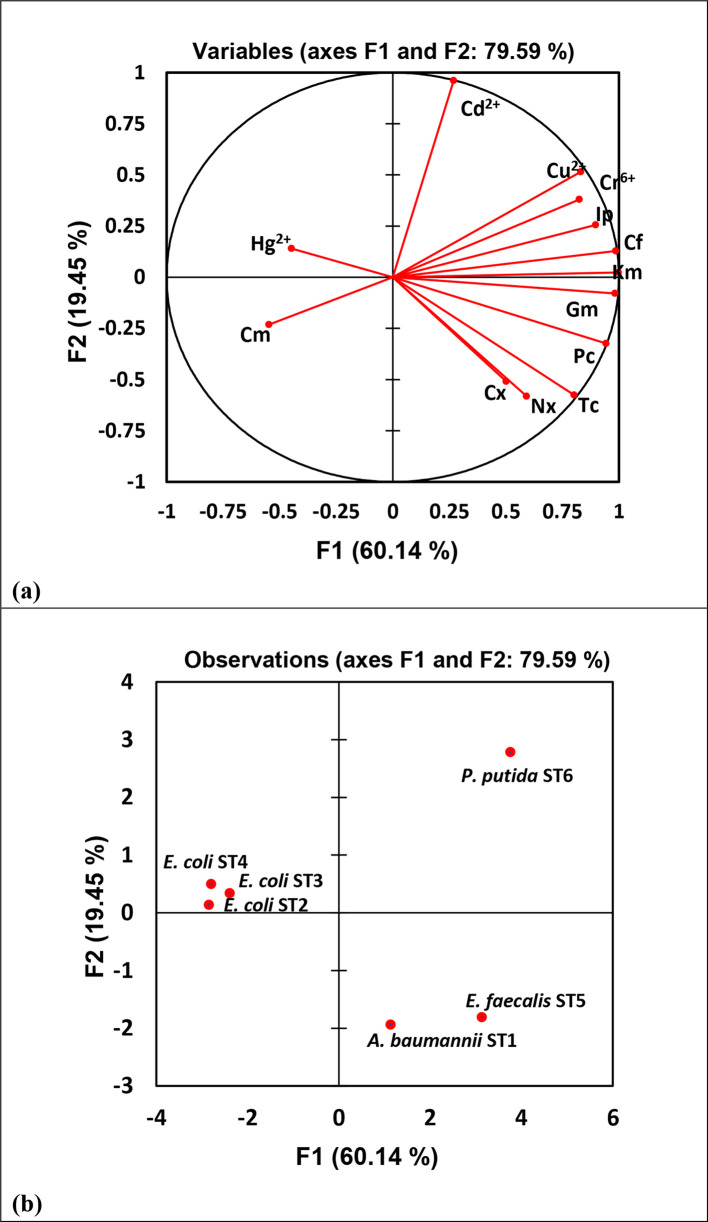
PCA of antibiotic resistance and heavy metal tolerance among sewage wastewater bacteria: (a) variable projection of F1 and F2 factors (antibiotics and heavy metals); (b) projection of six sewage bacterial isolates in F1 and F2 factors.